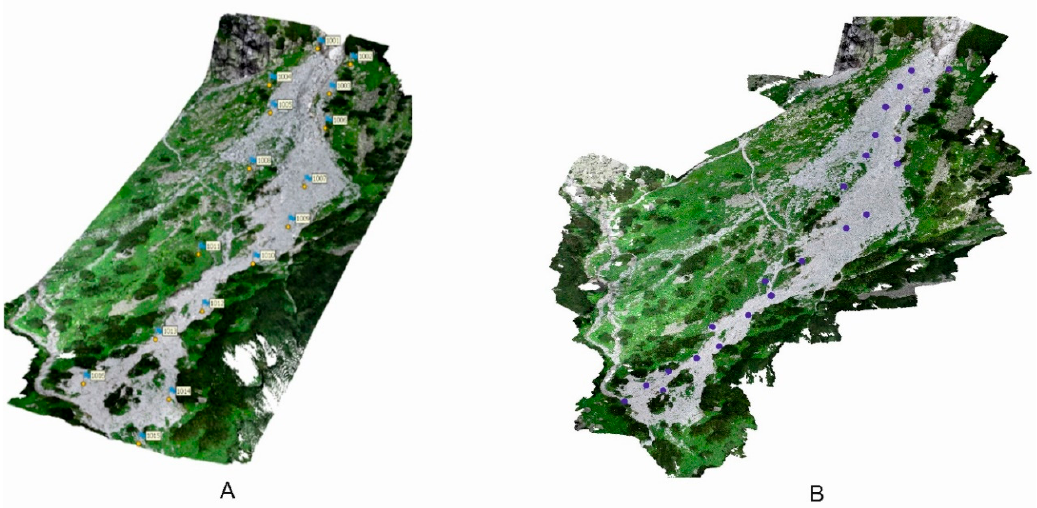
Figure 7. ( A )—Ground control points (GCPs) for the unmanned aerial system (UAS) measurement; ( B )—Leica P40 survey stations.